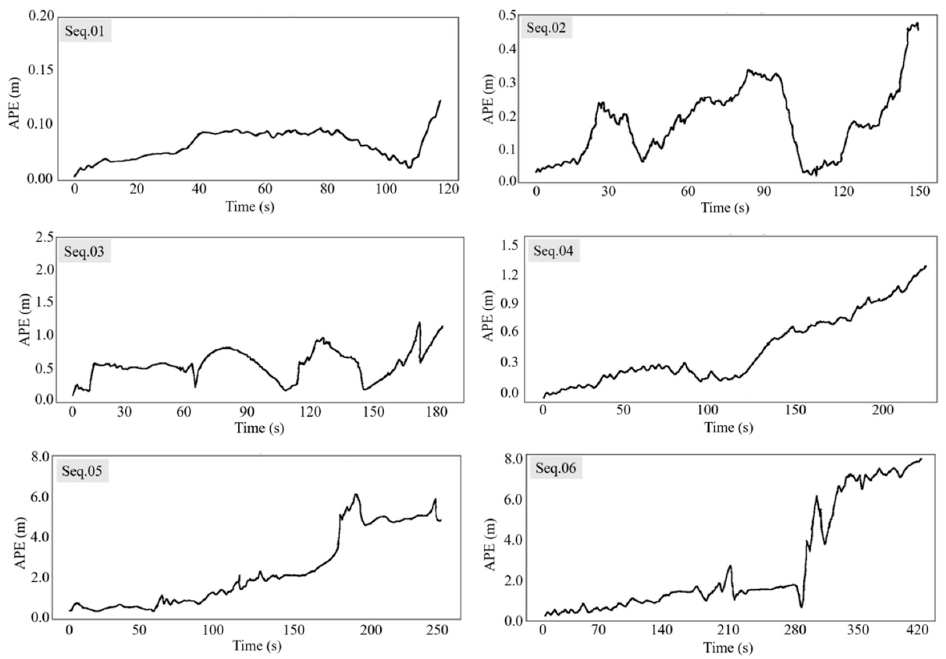
Figure 6. Absolute Pose Error in 6 sequences. Trajectories were aligned and depicted by EVO tools for both methods along with GPS ground truth, as shown in Figure 8. Our proposed method outperforms the ORB- SLAM2 on most sequences, except Seq. 06 (Figure 9). The results also show that loop clo- sure has little effect on reducing drift, which is explained in Section 5.